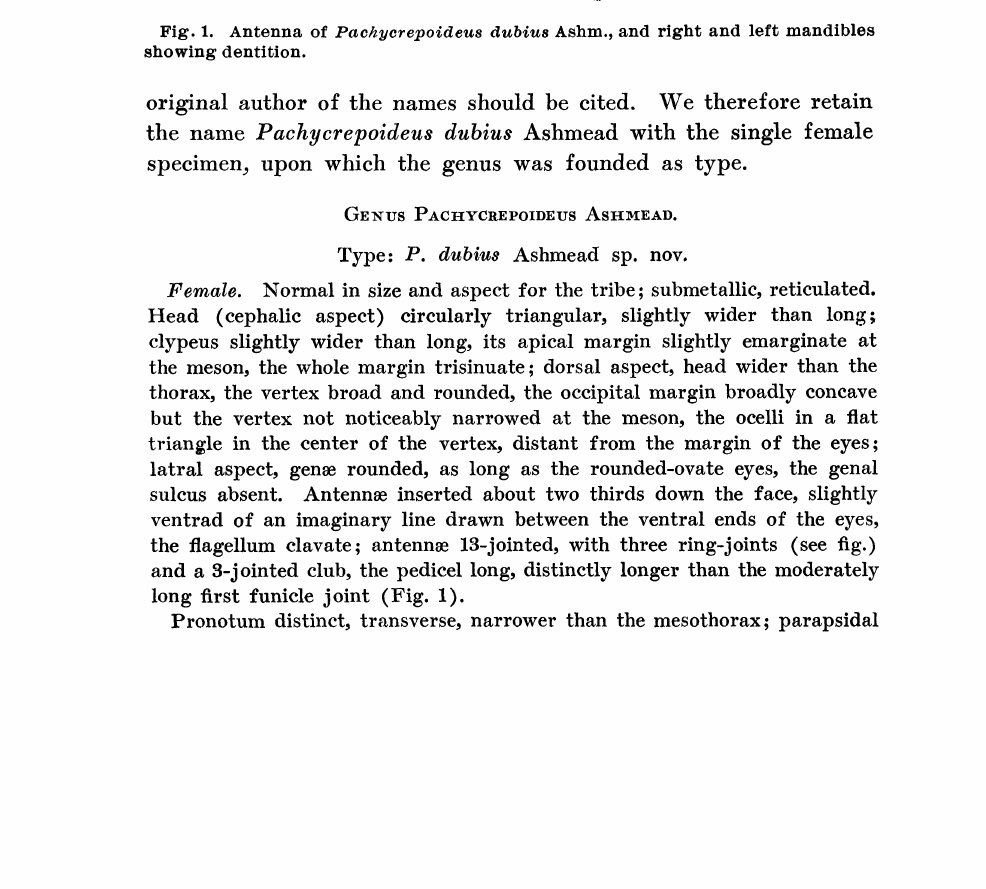
Fig. 1. Antenna of Pachycrepoideus dubius Ashm., and right and left mandibles showing